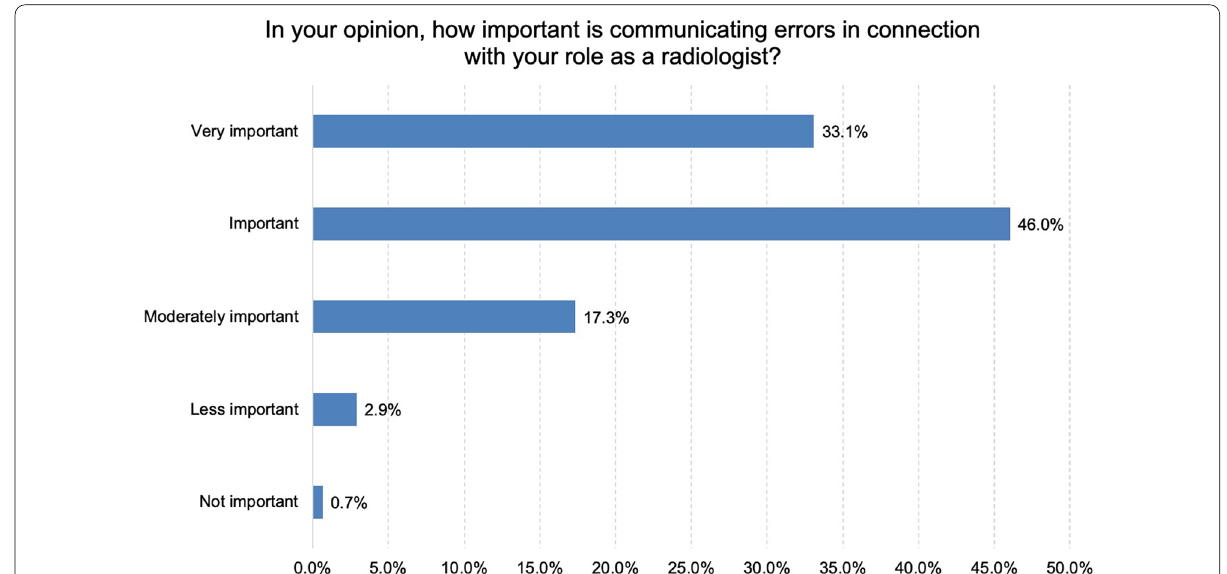
Fig. 13 In your opinion, how important is communicating errors in connection with your role as a radiologist? (responses n